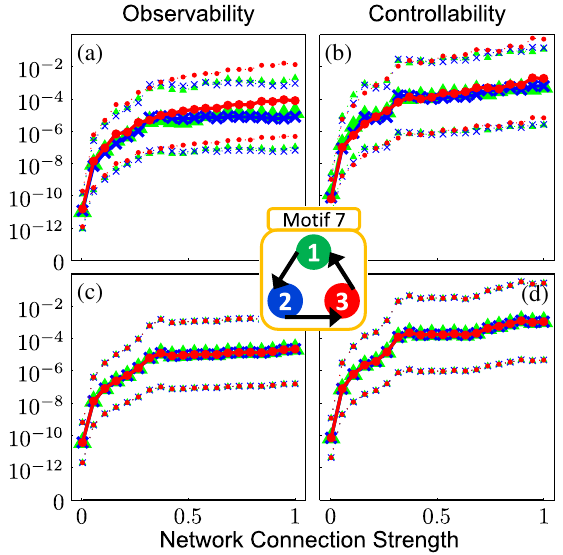
FIG. 4. Same as Fig. 2, except calculations are for motif 7. The calculations show that the particular rotational symmetry in the network topology has no ill effect on observability and control- lability for the symmetric case of identical coupling strengths (c), (d) as compared to the broken symmetry in panels (a) and